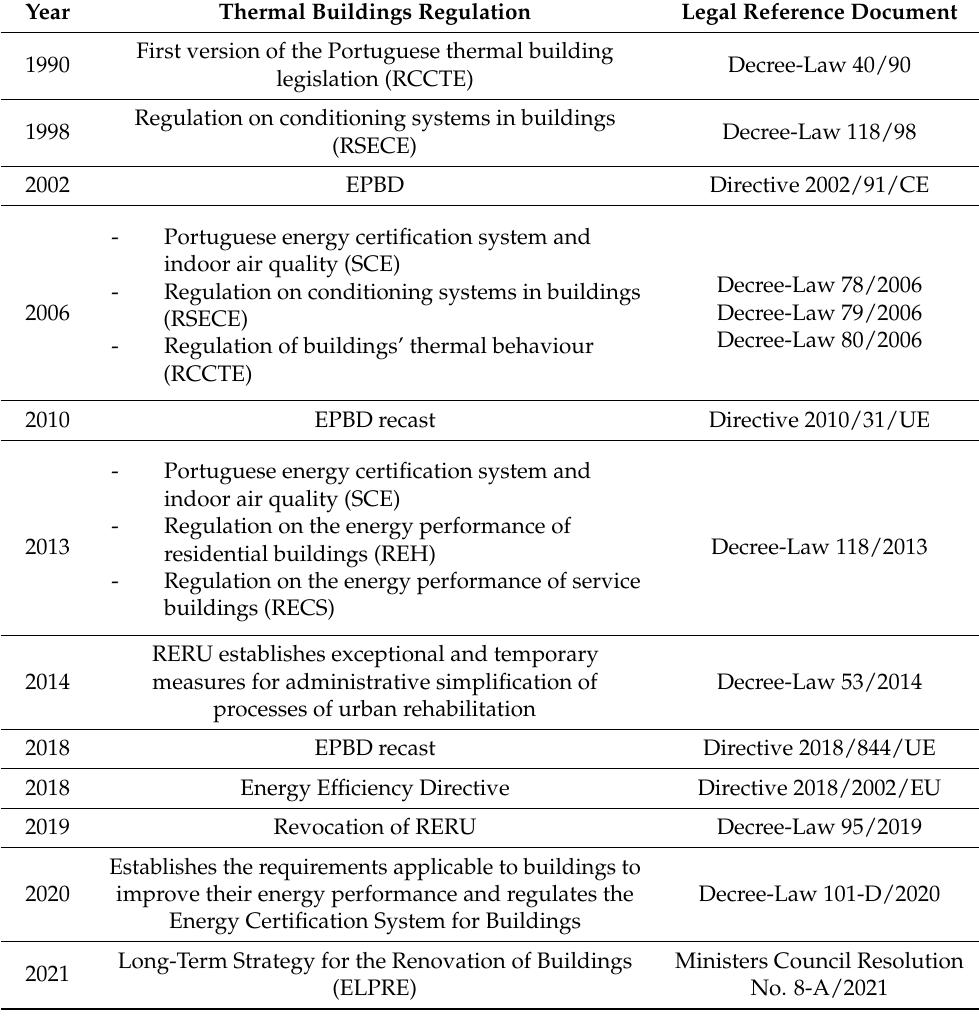
Table 1. Timeline of main thermal building regulations in Portugal and Europe between 1990 and